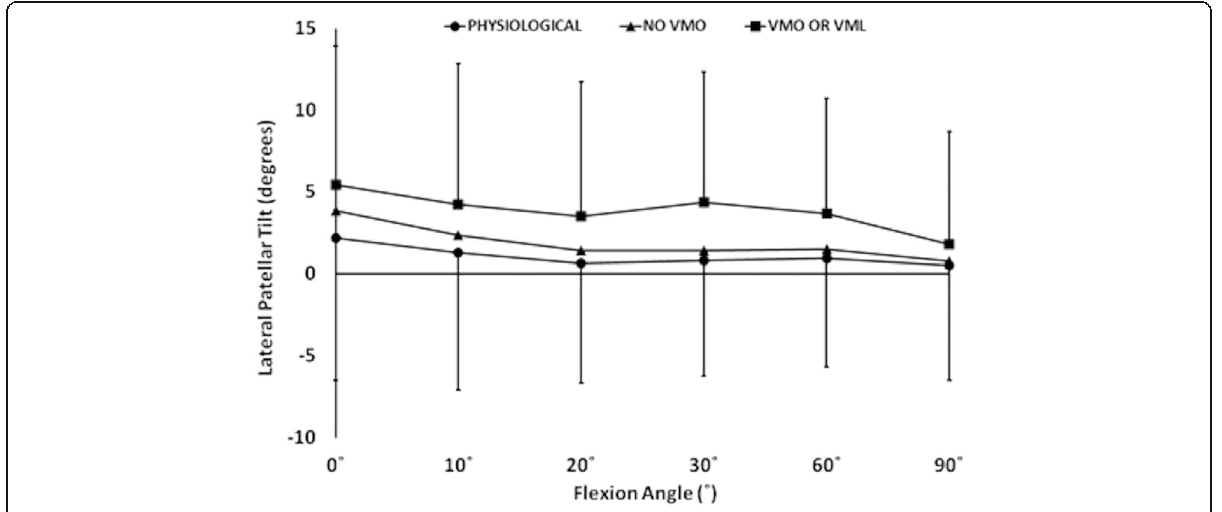
Fig. 3 Patellar lateral tilt (°) across knee flexion (mean +/- SD; n=9)